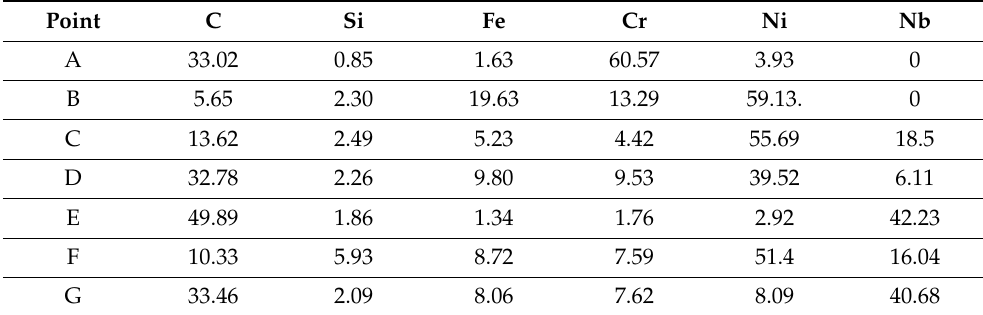
Figure 17. Observation of SEM Microstructure ( a ) 1#; ( b ) 2#; ( c ) 3#; ( d ) 4#; ( e ) 5#; and ( f ) 6#. Table 6. Chemical composition of A–G points